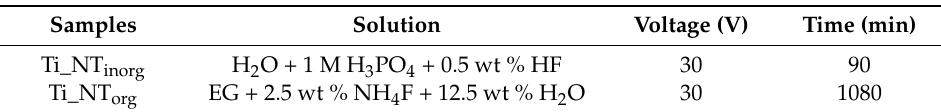
Table 1. Summary of parameters used during the anodic oxidation process conducted in the “inorganic” or “organic”